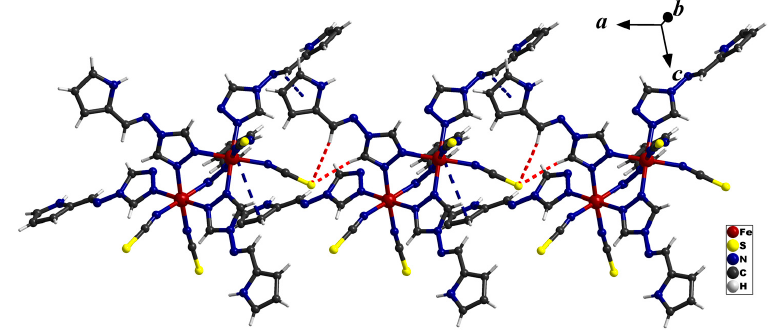
Figure 3. The 1D chain connected via different intermolecular interactions along a axis. The red dashed lines represent H-bonding, while the blue dashed lines represent π ⋅⋅⋅ π stacking.